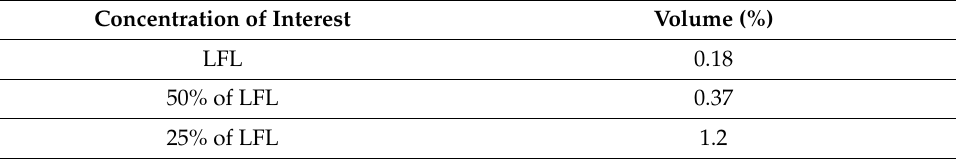
Table 11. Volume according to the concentration of interest.